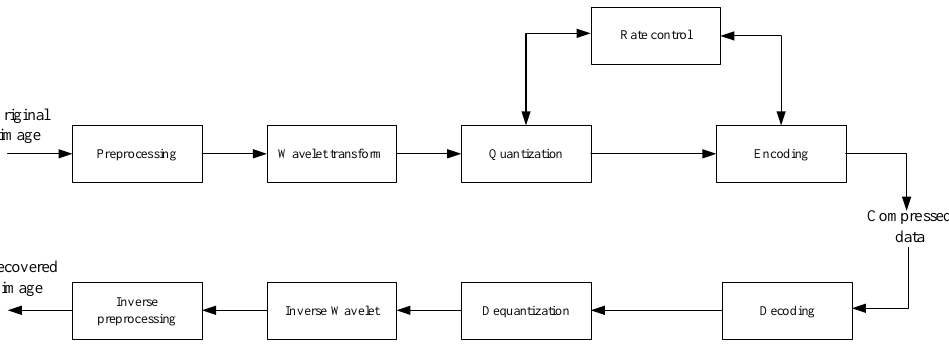
Figure 9. The processing of JPEG200 encoding and decoding.